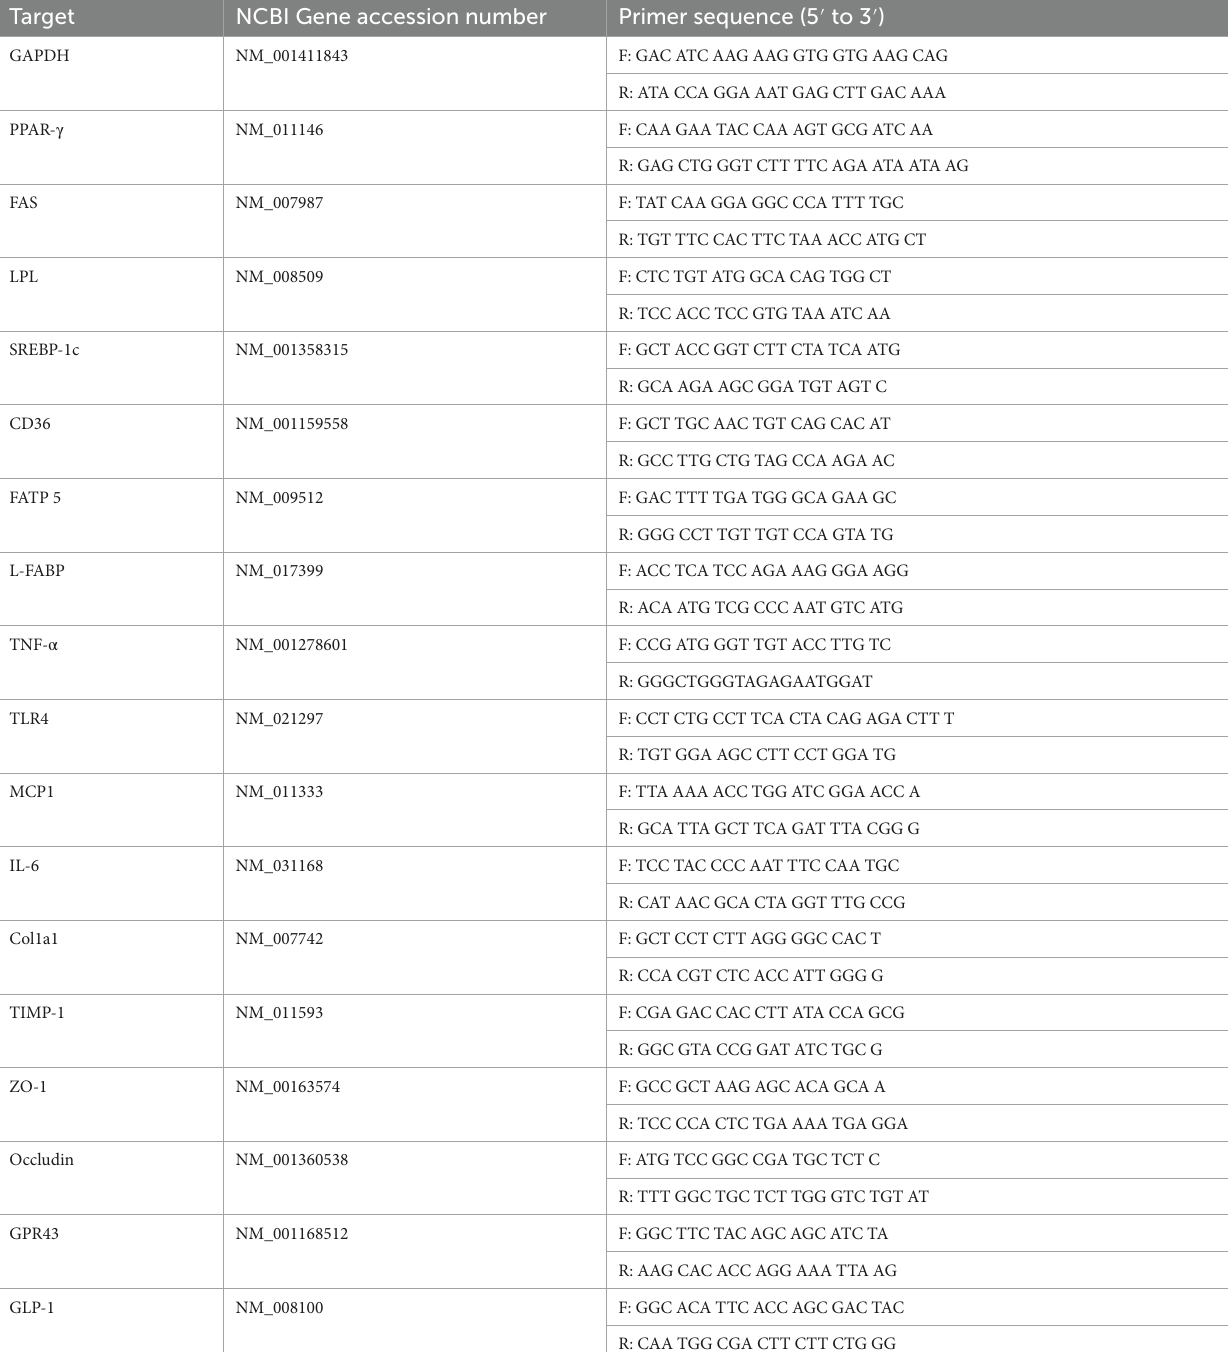
TABLE 2 Forward primer (F) and reverse primer (R) sequences used for PCR analyzes. Target NCBI Gene accession number Primer sequence (5 ′ to 3 ′